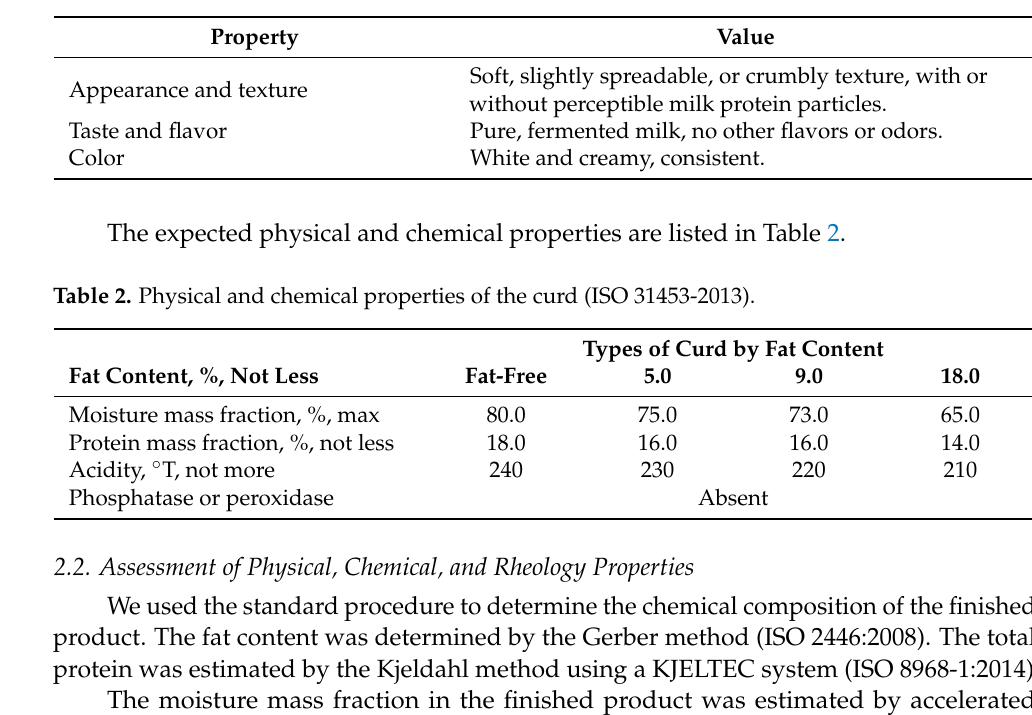
Table 1. Organoleptic properties of the curd (ISO